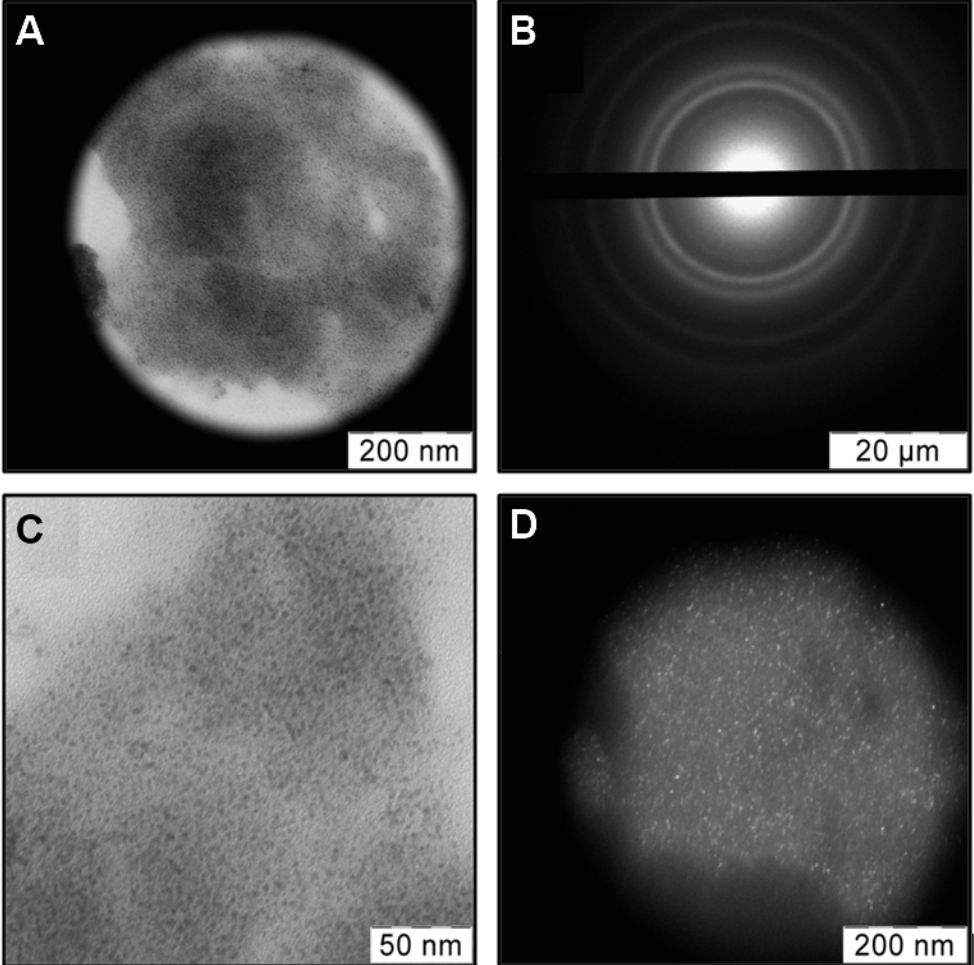
Figure 3. TEM images in bright ( A , C ) and dark fields ( D ) of chitosan with a high molecular weight (ChitHMW) doped with copper nanoparticles (Cu NPs) as well as SAED ( B ) of highlighted field.